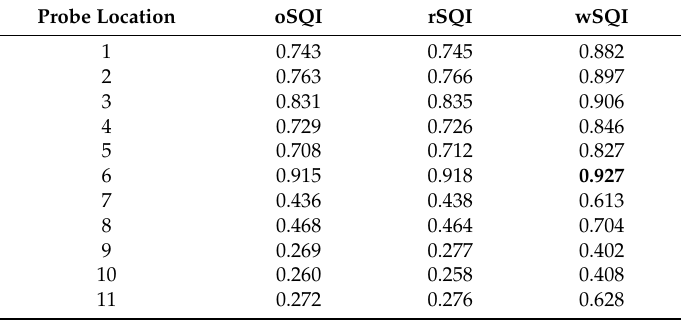
Table 1. Comparison of the mean SQI values obtained for p1 with F17 for all time